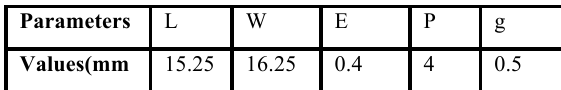
Table.2: AMC unit cell